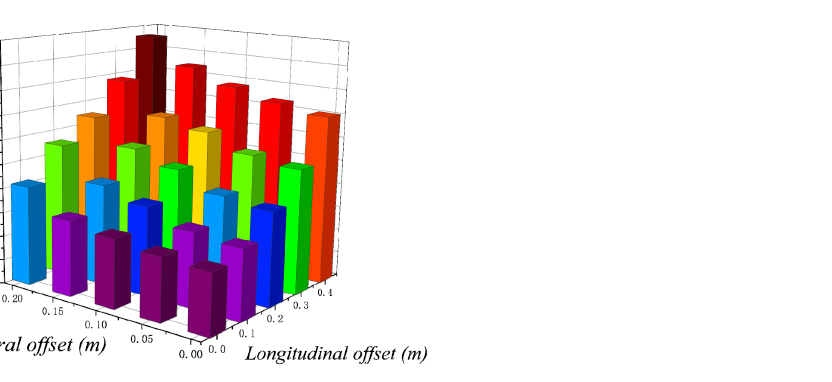
Figure 9. Influence of the shift of the center of gravity on the power consumption of the robot.